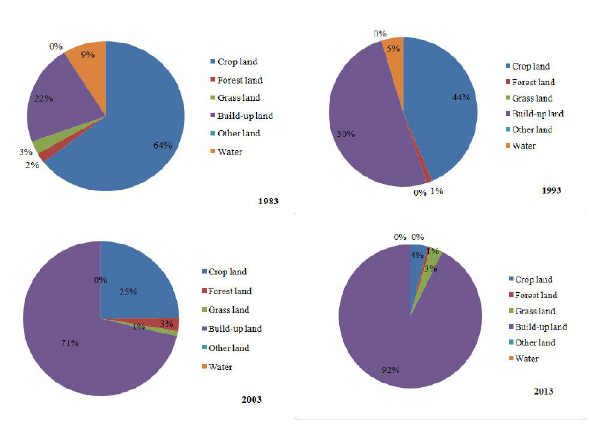
Figure.12 Temporal variation of different land cover ratio by Landsat TM between 1983 and 2013, Malianwa